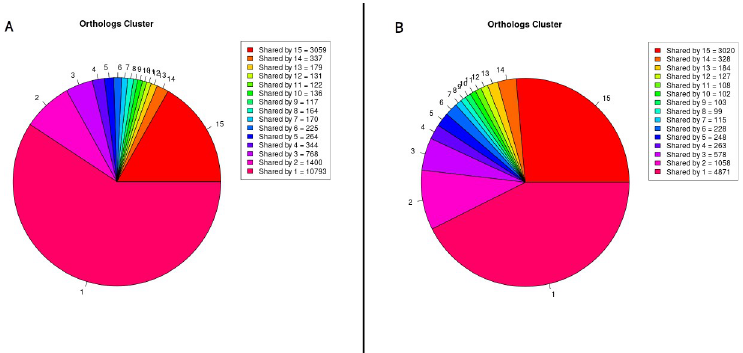
Fig 4. Orthologs genes. Pie chart representing the genes shared between strains using PAN2HGENE (A) and PGAP (B) analyses.